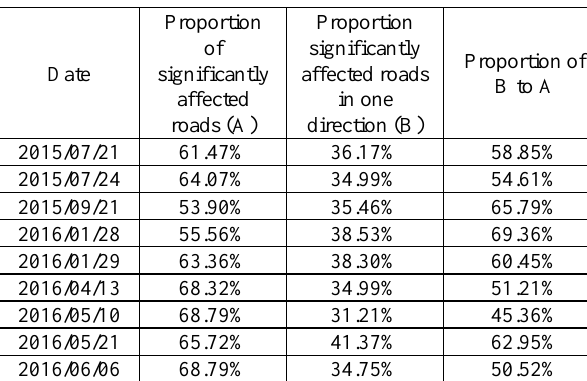
Table 3. Statistic of affected roads